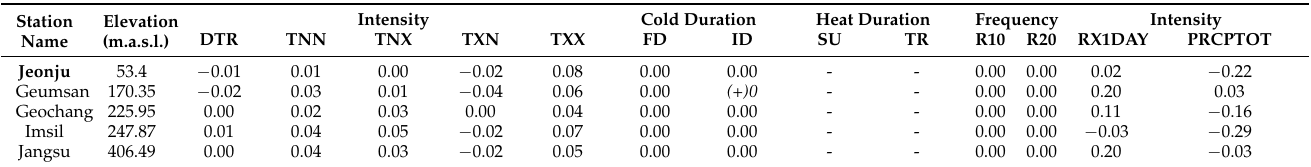
Table A8. Trend magnitudes for the month of February in the UGRB for 33 years (1988–2020).